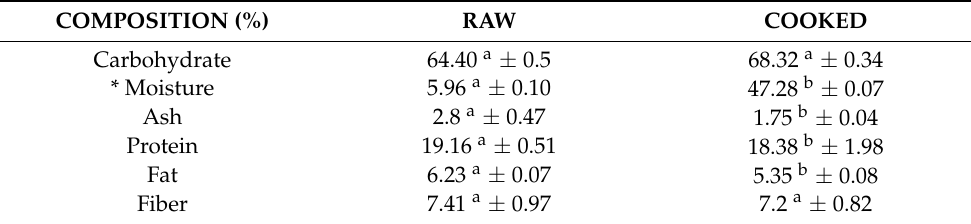
Table 1. Proximal composition of raw and cooked chickpea. COMPOSITION (%) RAW COOKED Carbohydrate 64.40 a ± 0.5 68.32 a ± 0.34 *